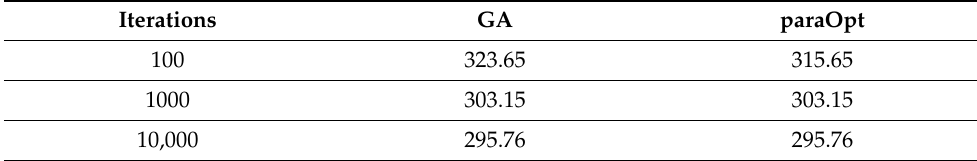
Table 6. Average Euclidean distance for Face Contour Approximation Model